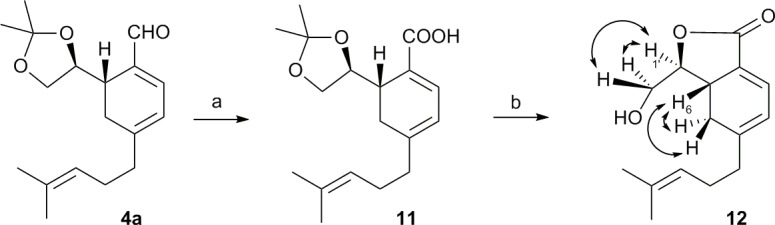
Synthesis of bicycle 12 from cyclohexadienal 4a.Reagents: a) NaH2PO4.H2O (2.2 equiv.), NaClO2 (5%, 2.2 equiv.), 2-methyl-2-butene, tBuOH, r.t., 2h, 99%; b) p-TsOH, MeOH, r.t., 30%.